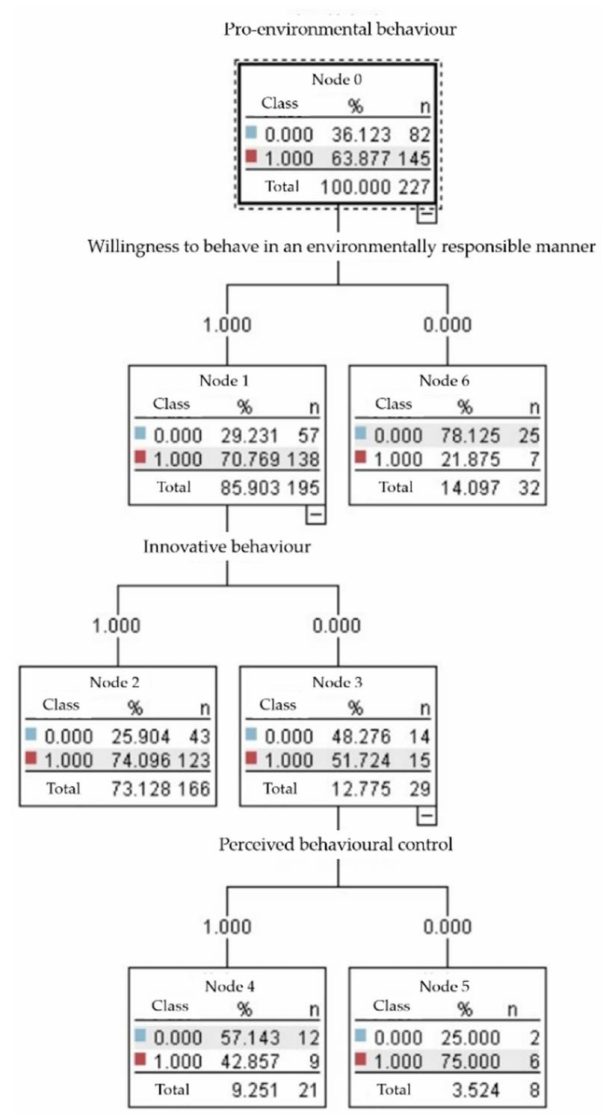
Figure 2. Predictive models for pro-environmental models.